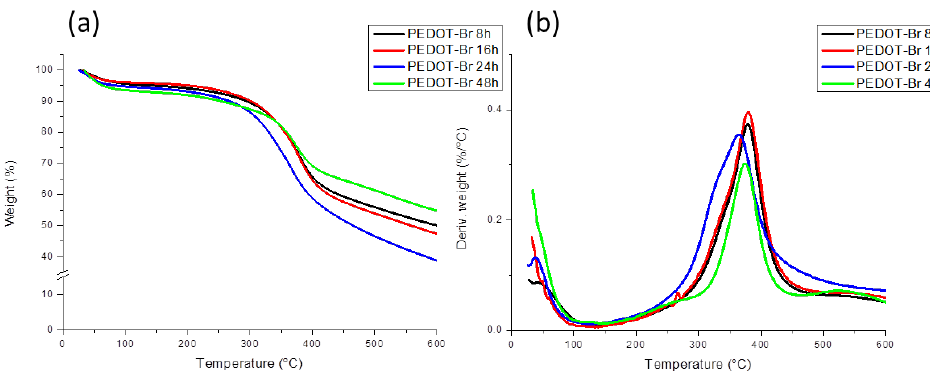
Figure 3. Thermogravimetric analysis of PEDOT-Br macroinitiators with different synthesis duration: ( a ) TG curves and ( b ) DTG curves of obtained products.